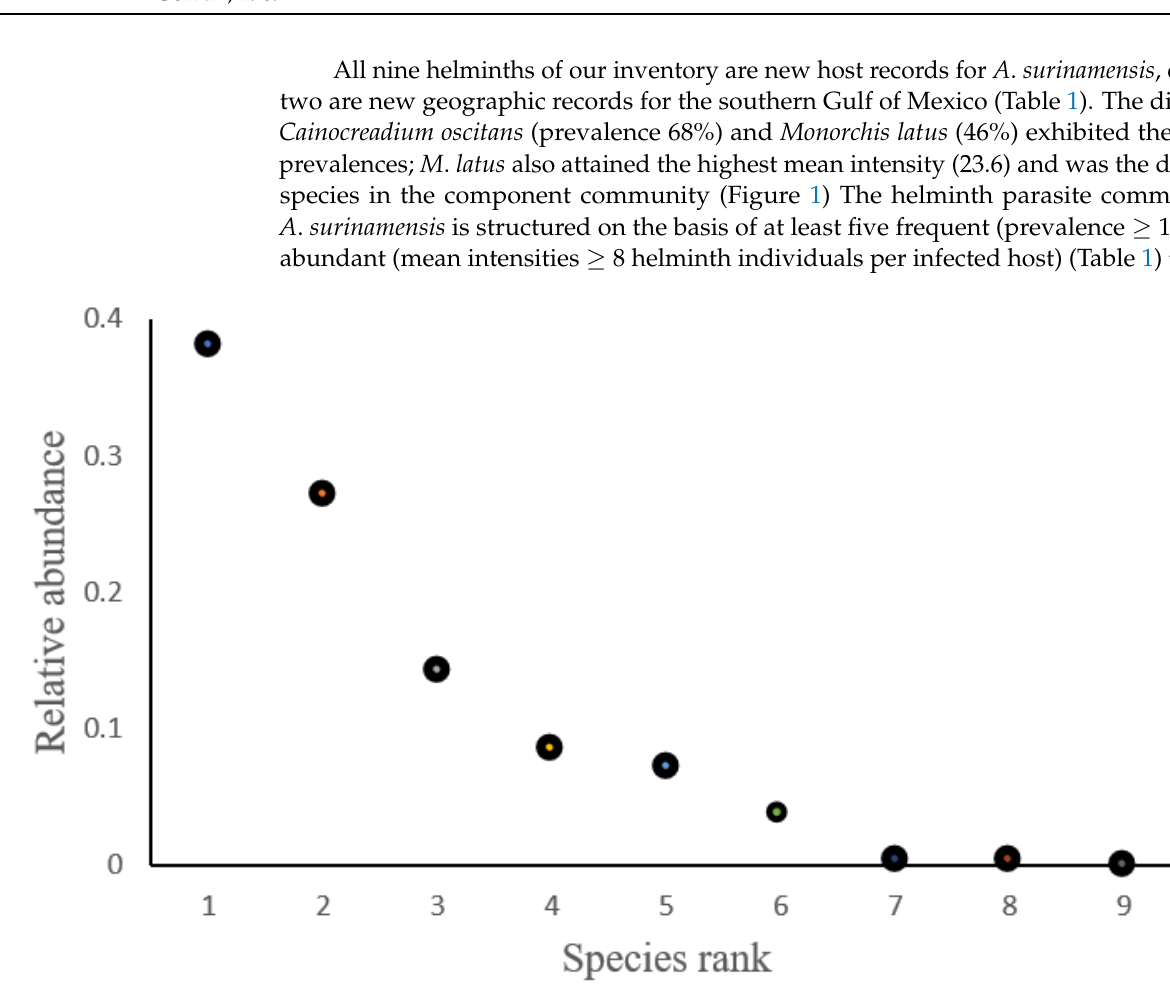
Figure 1. Pattern of relative abundance of nine taxa of helminths in the component of community of A . surinamensis from coral reef environments of Veracruz, Mexico. The dominant helminth species is Monorchis latus .